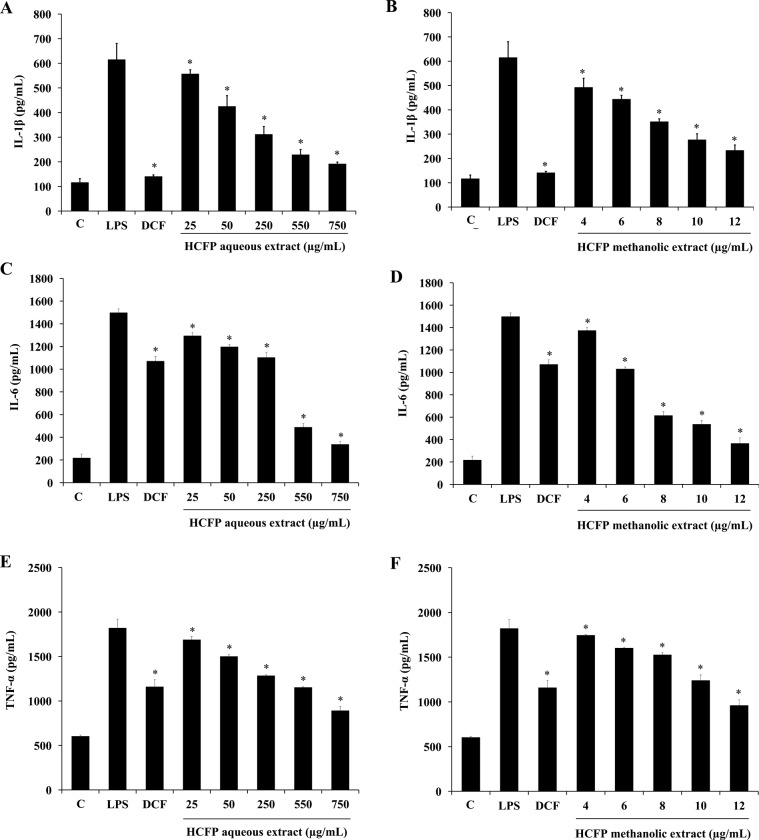
Effect of HCFP on production of IL-1β (A, B), IL-6 (C, D) and TNF-α (E, F) in LPS-stimulated RAW264.7 cells. The cells were pre-treated with the indicated concentration of aqueous extract or phenolic extract for 2 h then stimulated with LPS (1 μg/mL) for 24 h. The IL-1β, IL-6, and TNF-α in cultured medium were determined by ELISA kits. Data were expressed as the mean±S.D. of two independent experiments. Statistically significant inhibitions of IL-1β, IL-6 and TNF-α production (*p < 0.05) were found as compared with the LPS group.